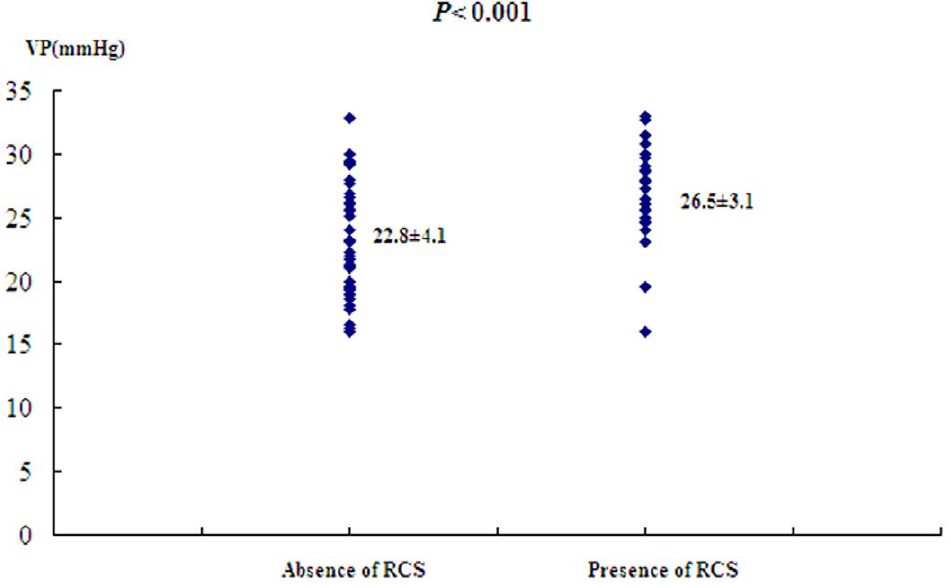
Figure 7. VP levels (mm Hg) measured by CEBM in correlation with the presences absence of red colour signs.